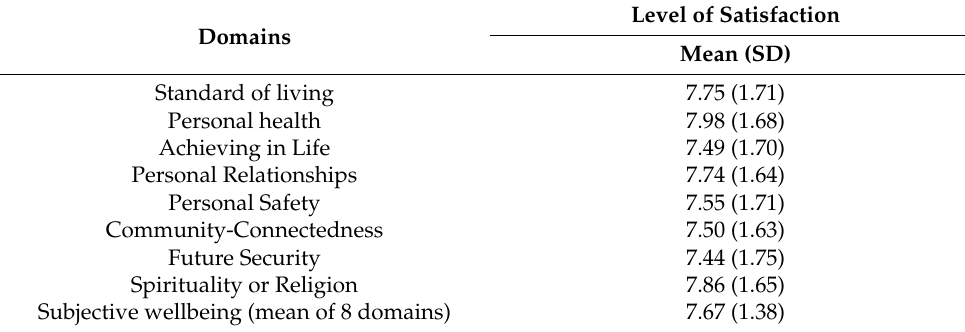
Table 4. Personal Wellbeing Index score among university community ( n =